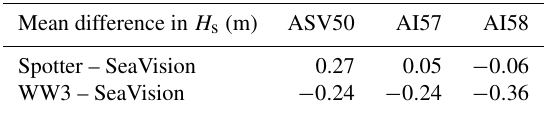
Table 4. Differences in significant wave height estimates for the three cruises. Mean difference in H s (m) ASV50 AI57 AI58 Spotter – SeaVision 0.27 0.05 − 0 .